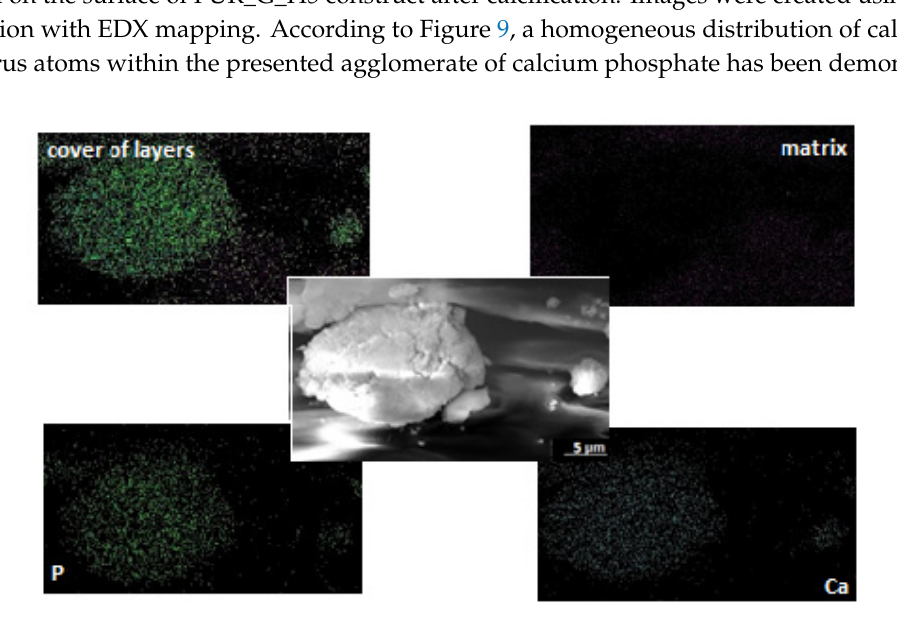
Figure 10. Distribution of elements in the sample of PUR30_G_H5 scaffolds.